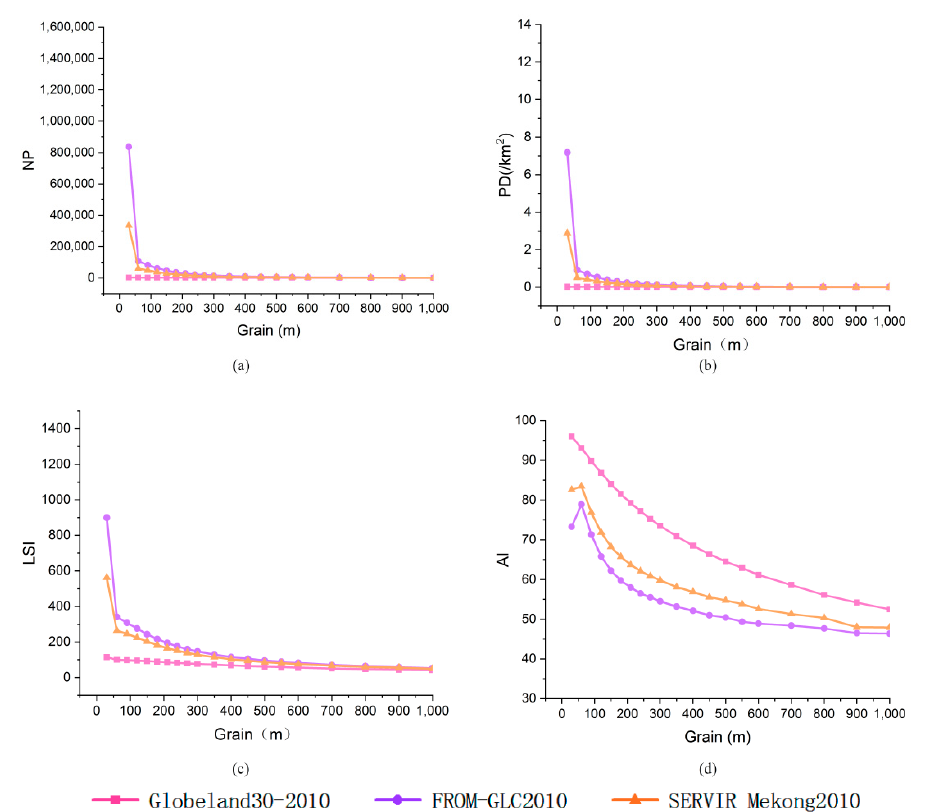
Figure 4. The cropland landscape pattern indices changing curves with scale increasing. ( a ) is the NP curve; ( b ) is the PD curve; ( c ) is the LSI curve; ( d ) is the AI curve.